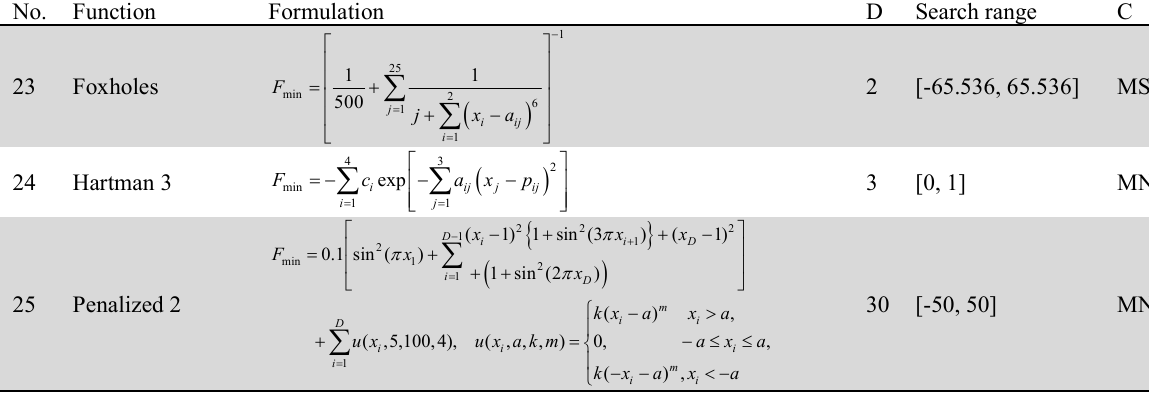
Unconstrained benchmark functions considered (Continued) No.